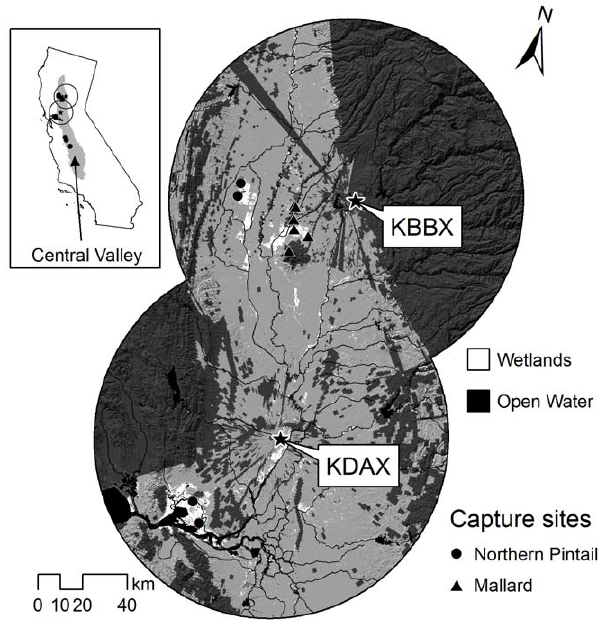
Figure 1. Study area within the Central Valley of California. Locations (stars) and names of weather radars and their associated 80 km radius surveillance areas are shown. Also shown are capture locations of radio-marked northern pintail and mallard during winters of 1998–1999 and 1999–2000. Dark grey-shaded areas denote where radar data were masked because of persistent ground clutter contamination or partial radar beam blockage.